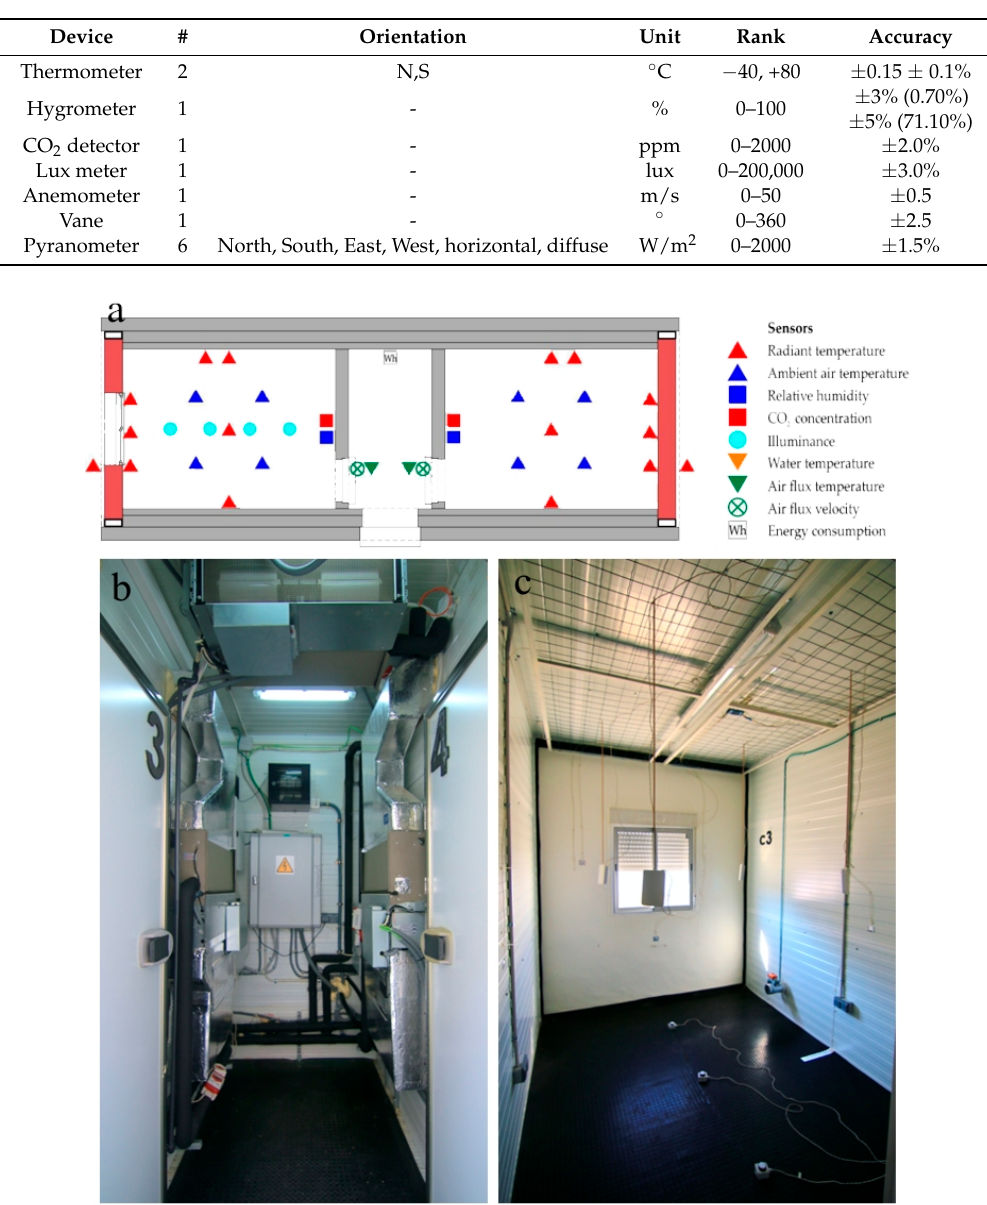
Figure 5. ( a ) Location of the sensors within each module; ( b ) Service room; ( c ) Test room (cell